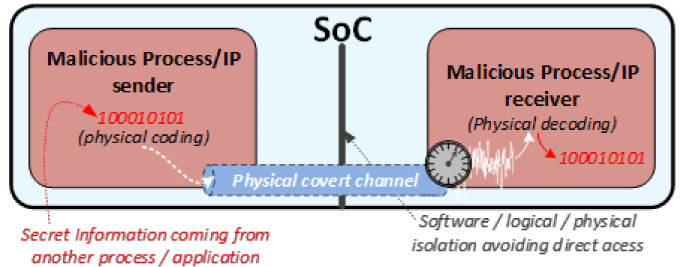
Figure 2. Conceptual view of an inside-SoC covert